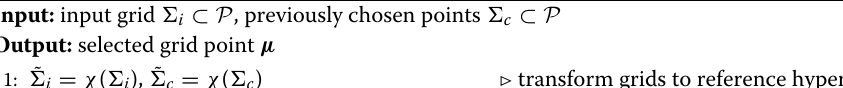
Algorithm 1 MaxiMinPoint( (cid:12) i , (cid:12) c ) (select a greedy MMD